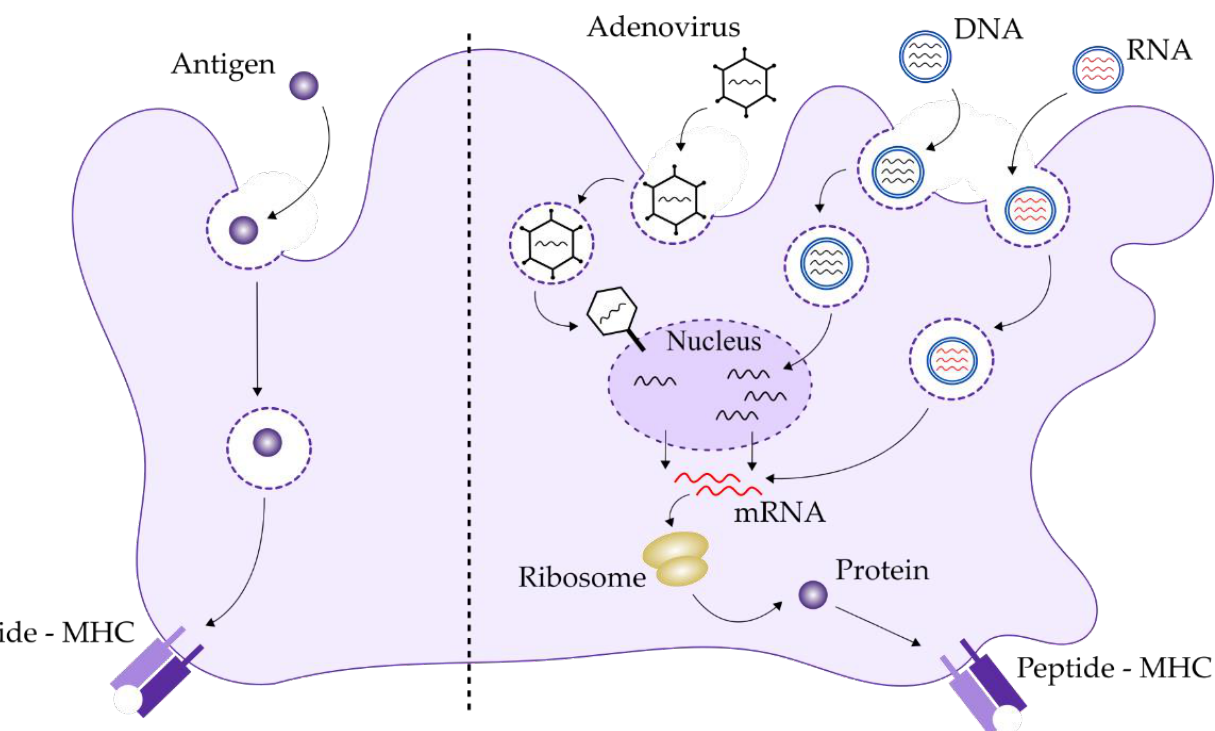
Figure 3. Schematic representation of the differences between conventional and nucleic acid-based vaccines. Conventional vaccines include inactivated pathogens, pathogen subunits or live-attenuated pathogens which are taken up by antigen presenting cells and presented to the immune system cells (on the left). On the other hand, nucleic acid-based vaccines (on the right) are delivered using adenovirus or liposomes which are able to fuse to the plasma membrane and released into the cytosol where the DNA vaccines enter the nucleus, and are transcribed and the mRNA is translated inside the ribosomes and the protein is presented to the immune system cells. RNA vaccines are released into the cytosol and translated inside the ribosomes and the polypeptide is presented to the immune system cells.